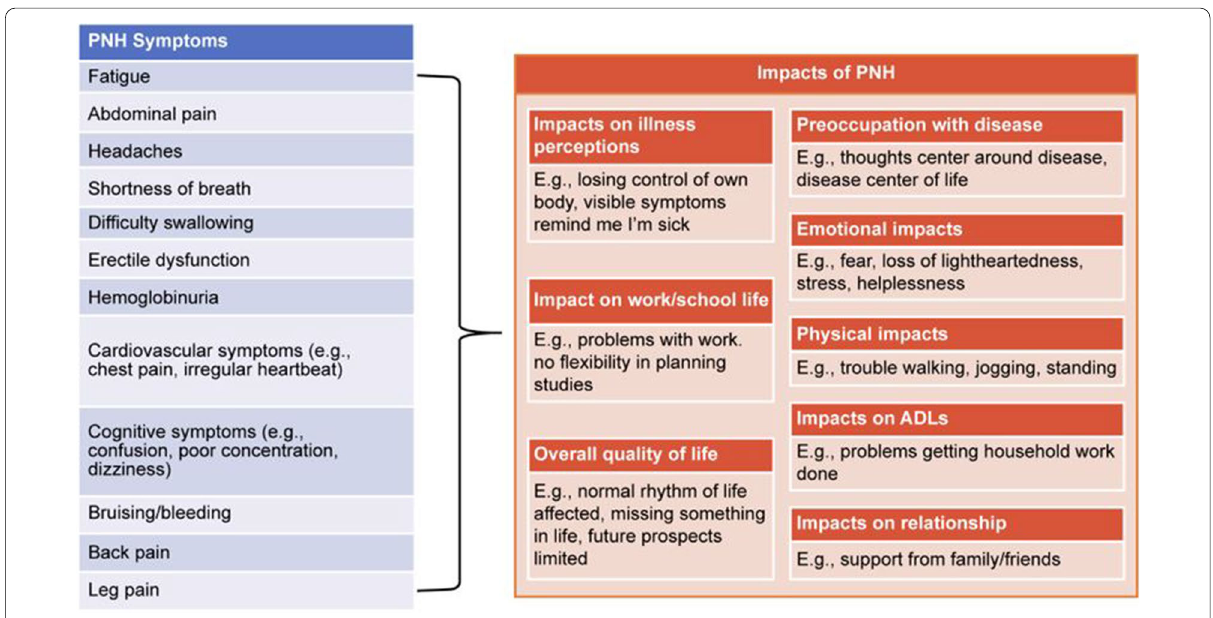
Fig. 2 Conceptual model of PNH. PNH , paroxysmal nocturnal